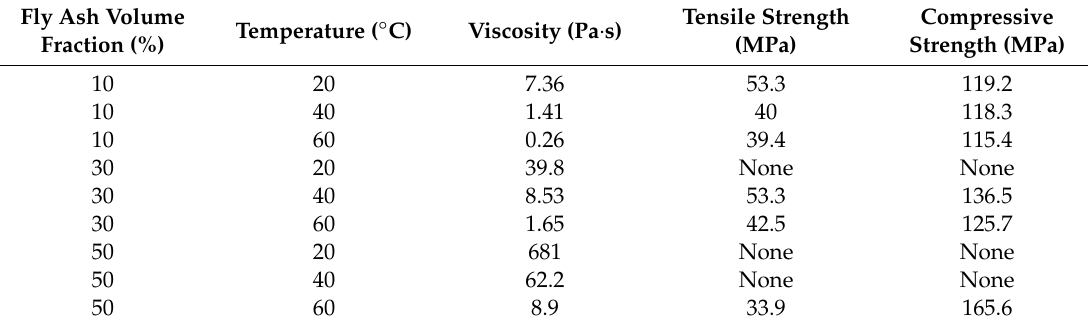
Table 4. Mechanical properties of fly ash filled epoxy composite at different temperature.